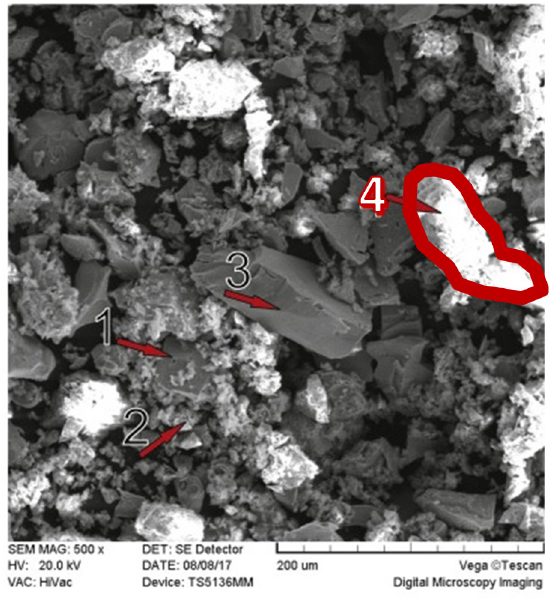
Figure 2. SEM image of the chalcopyrite leaching residue after 120 min of leaching in 1.5 mol/L of [H 2 SO 4 ], 2 mol/L of [H 2 O 2 ], and 2 mol/L of isopropanol solution at 65 °C (Modified from [51]).